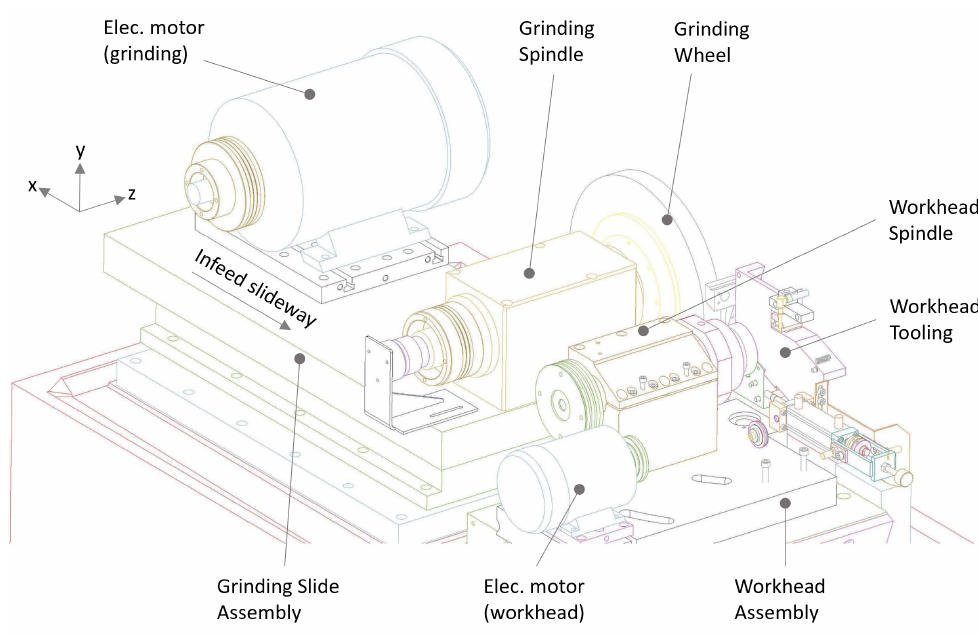
Figure 4. SGB55’s critical subsystems for sensor installations as part of CBM implementation.